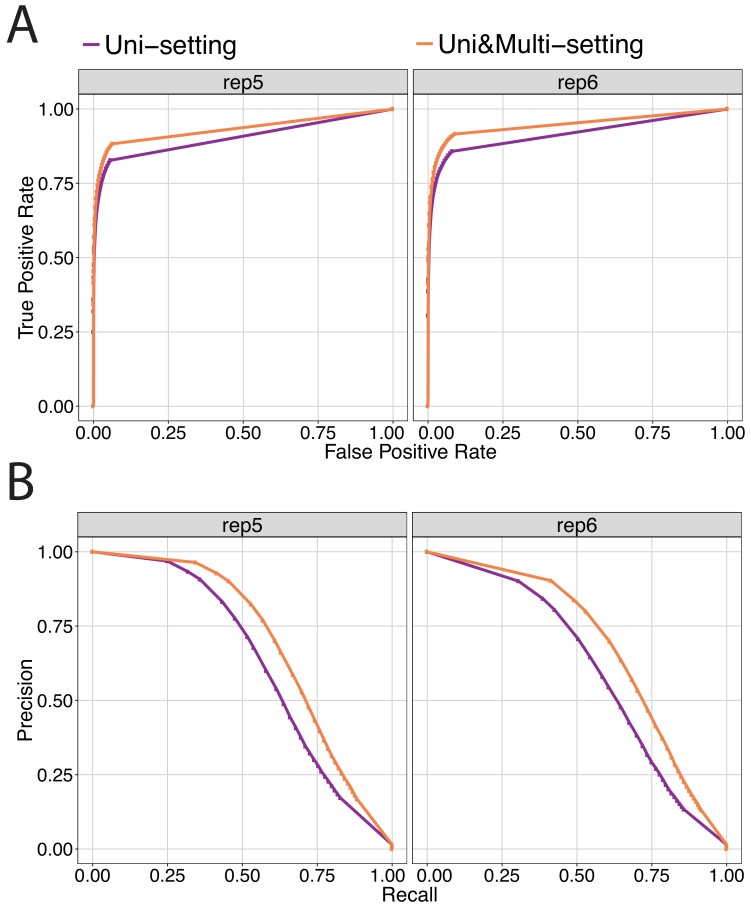
ROC and PR curves for replicates 5 and 6 of IMR90.Sets of ‘True’ interactions and ‘True’ non-interactions are defined by reproducible significant/insignificant interactions across replicate 1–4 of both Uni-setting and Uni&Multi-setting (See Materials and methods). Significant interactions of replicates 5 and 6 are utilized to compare ROC (A) and PR (B) curves among the Uni- and Uni&Multi-settings.